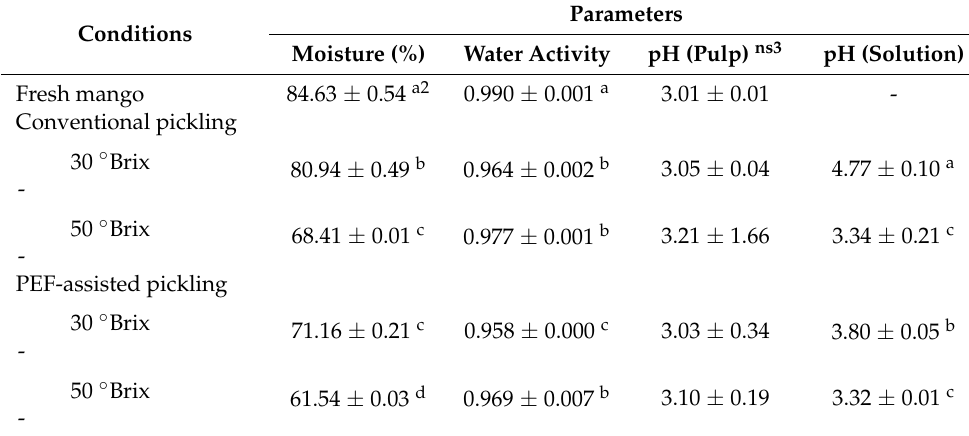
Table 1. Moisture content, water activity, and pH for the conventional and PEF-assisted